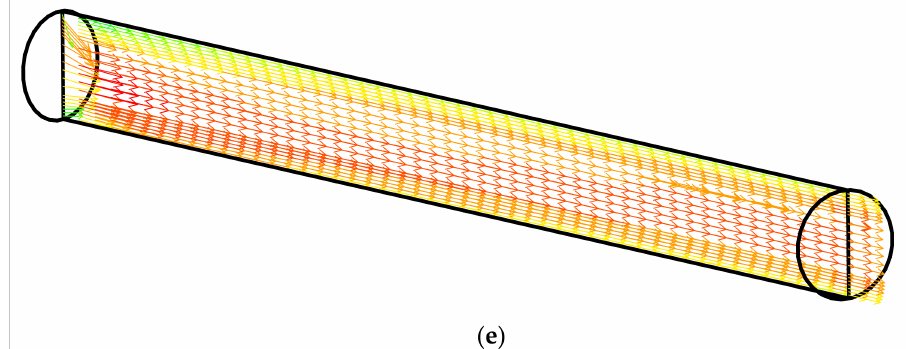
Figure 8. Flow pattern in the tundish without channel induction heating. ( a ) Streamline at vertical plane, × = − 0.379 (YZ plane); ( b ) velocity vector in the inlet of channel Y = 0.775 (XZ plane); ( c ) velocity vector in the middle of channel Y = 1.635 (XZ plane); ( d ) velocity vector in the outlet of channel Y = 2.51 (XZ plane); ( e ) velocity vector in the channel × = − 0.379 (YZ plane).